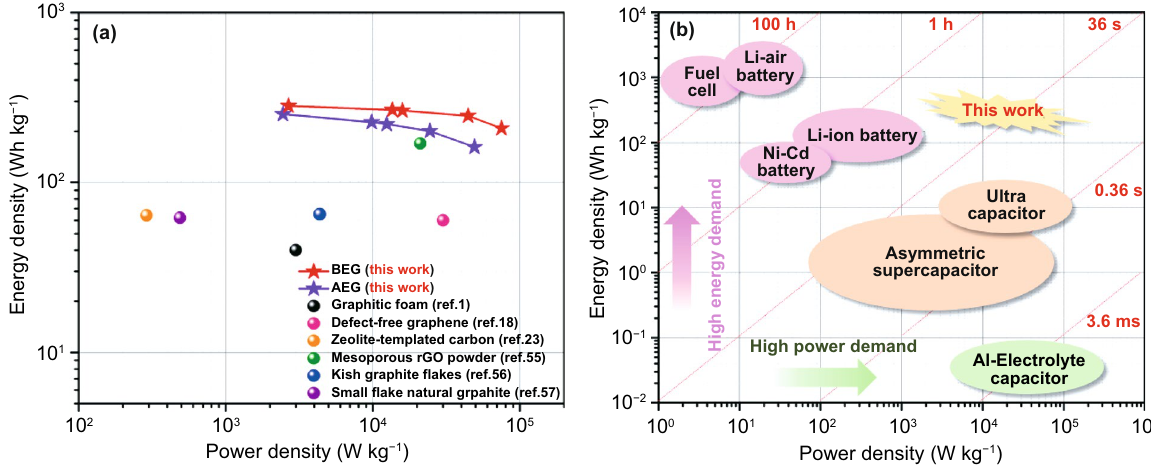
Fig. 6 Ragone plot of energy density vs. power density for AEG and BEG cathodes: comparison with a state-of-the-art graphitic carbon materi- als reported in the literatures and b other energy storage